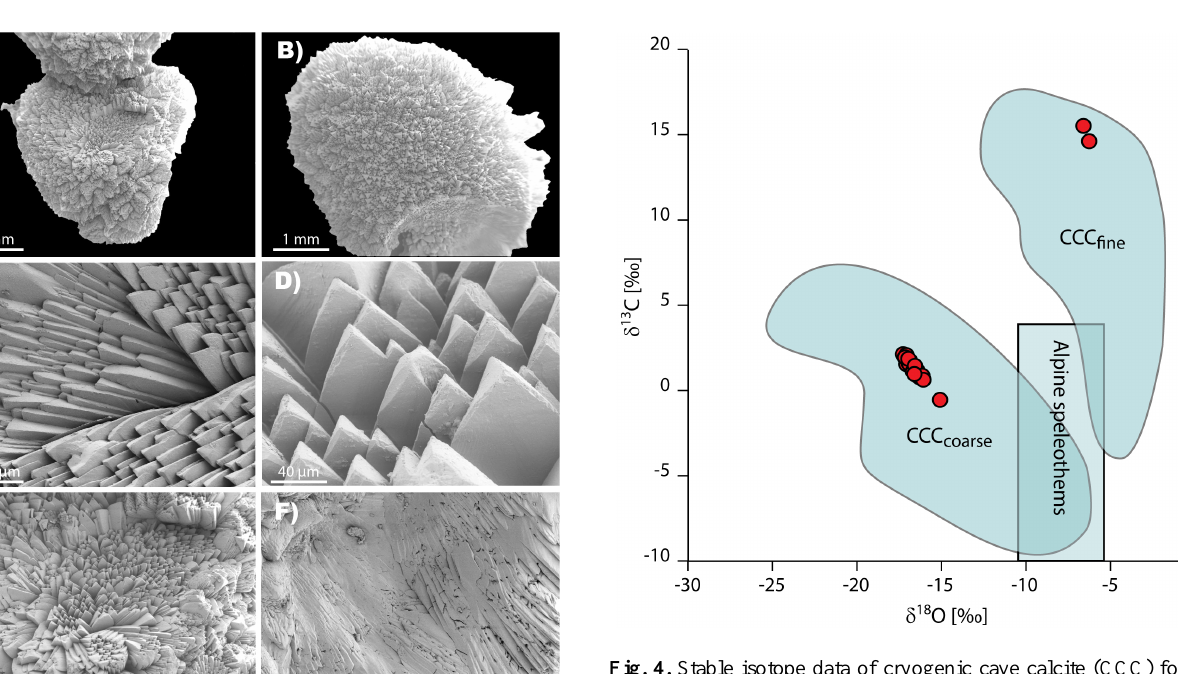
Fig. 4. Stable isotope data of cryogenic cave calcite (CCC) found in Leclanch´e Cave (red dots). Values from Central European caves (blue areas; ˇZ´ak et al., 2012 and references therein) are shown to- gether with the typical range of Alpine speleothems (unpublished data of the authors).